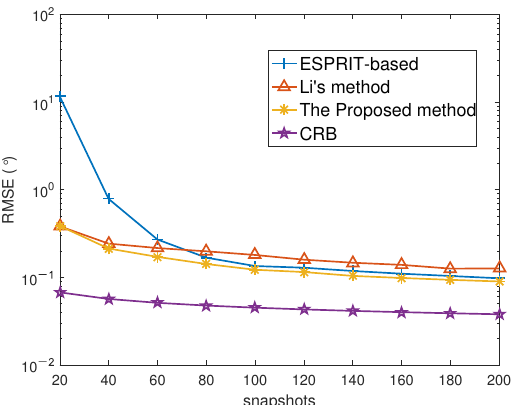
Figure 7. Angle estimation RMSE performance versus the number of snapshots, SNR = 20 dB.